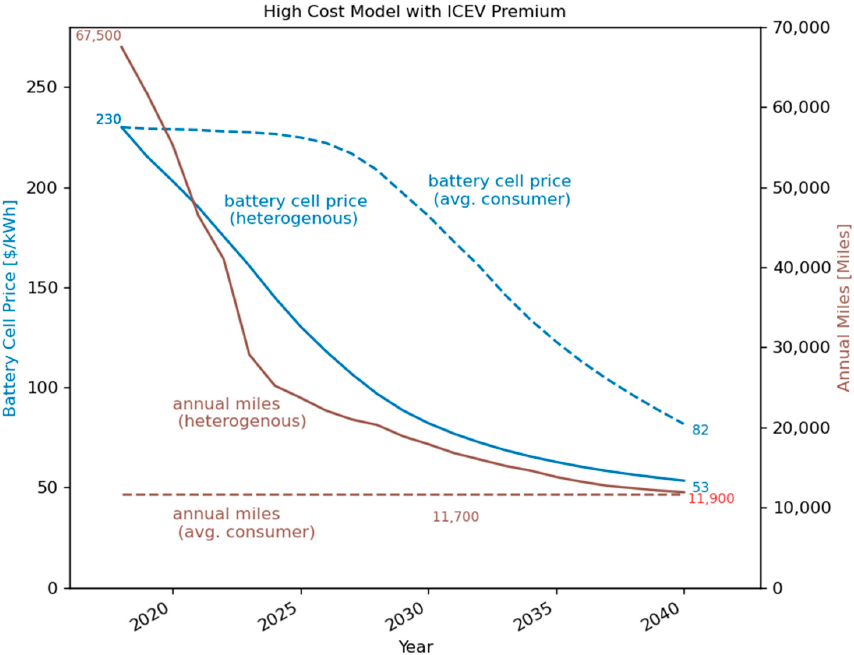
Figure 2. Forecast battery cell price (USD per kWh, blue lines and left axis) and Average Annual Miles (brown lines, right axis) driven by consumers adopting ETVs, accounting for heterogeneity (different miles driven, lifetime, and fuel prices) in consumer behavior (solid lines) versus non-heterogeneous (average) consumers (dashed lines). All results assume the High Non-Battery Cost Model with ICEV Cost Premium, gasoline price = USD 2.60/gallon (EUR 0.65 per liter). Note that accounting for heterogeneity leads to more rapid cost reductions by identifying early sub-populations that benefit from and thus prefer BEVs, PHEVs, or Hybrids over ICEVs. The annual miles driven for early-adopting subpopulations are significantly higher than the average consumer’s annual mileage (11,700 miles = 18,800 km). As battery costs fall, ETVs become economically attractive to more consumers, eventually being preferred by almost all drivers by 2040. In contrast, assuming that all consumers are average implies that adoption of ETVs and resulting cost reductions are slower. (HEV = Hybrid Electric Vehicle, BEV = Battery Electric Vehicle (BEV), PHEV = Plug-in Hybrid Electric Vehicle, ICEV = Internal Combustion Engine Vehicle).